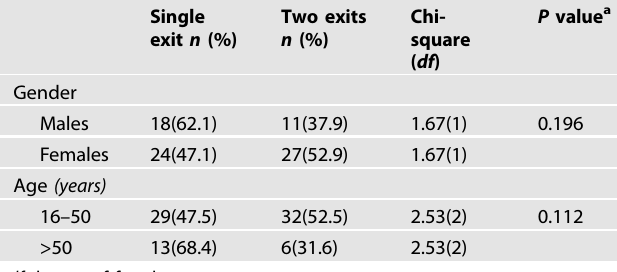
Table 5. Overall association of the different demographic factors with the number of MB-2 exit(s) in maxillary fi rst molars ( n = 80).